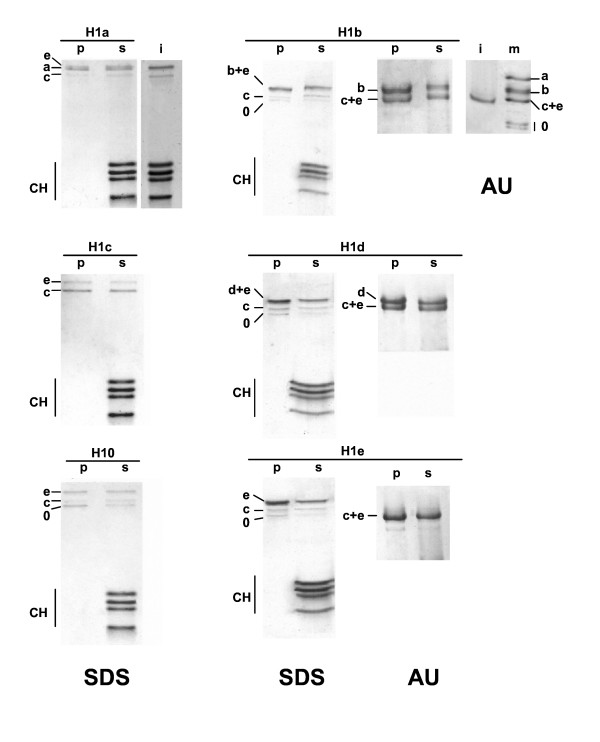
Perturbation of the H1 complement of native chromatin. A sample of chromatin (30–35 nucleosomes) containing 30 μg of DNA was mixed with ~8 μg of SAR DNA and ~3 μg of one of the subtypes H1a-e and H1°. This amount of added H1 corresponds to ~0.4 molecules per nucleosome. The insoluble complex of SAR and H1 (p) was separated by centrifugation from chromatin (s) with its H1 complement redefined. Perturbation experiments with H1a, H1c and H1° were analyzed only by SDS gel electrophoresis. Experiments with H1b, H1d and H1e were analyzed by SDS and urea/acetic acid gel electrophoresis. Chromatin inputs analyzed by SDS and AU gel electrophoresis are shown (i). m, mixture of H1 subtypes separated by AU gel electrophoresis. The subtypes H1a-e and H1° are indicated (a-e, 0). CH, core histones.